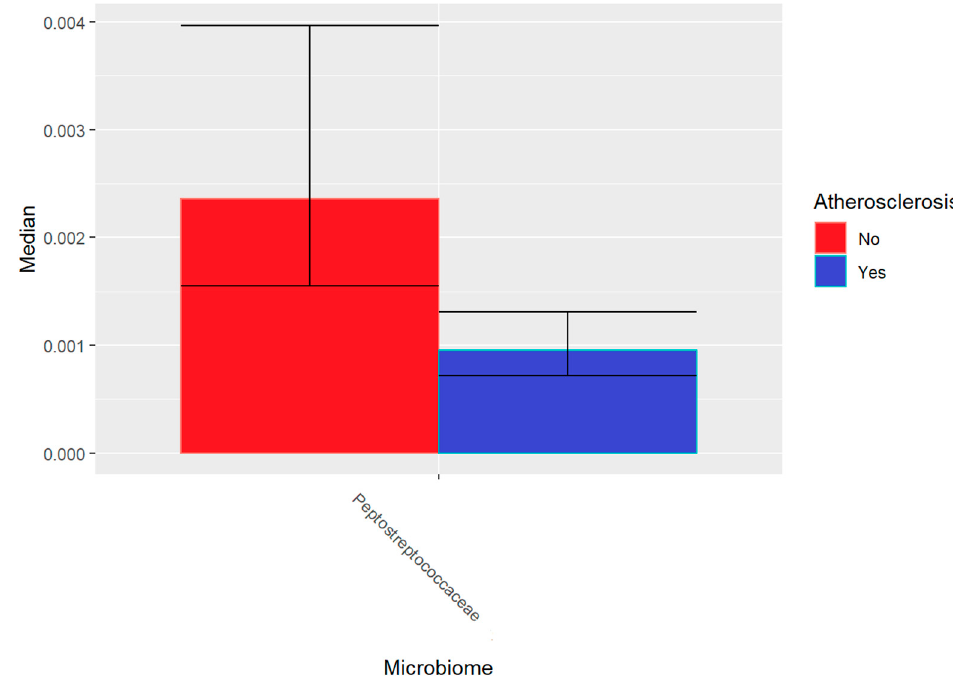
Figure 17. The median and the interquartile range of the fractions of Peptostreptococcaceae . Without correction, where p < 0.05 for the permutation test, in the two groups the candidate microbes at the genus level were Bilophila , Romboutsia , Slackia , and Veillonella in the non-atherosclerotic group; and Escherichia-Shigella , Prevotella , and Ruminococcaceae in the atherosclerotic group (Figure 18).